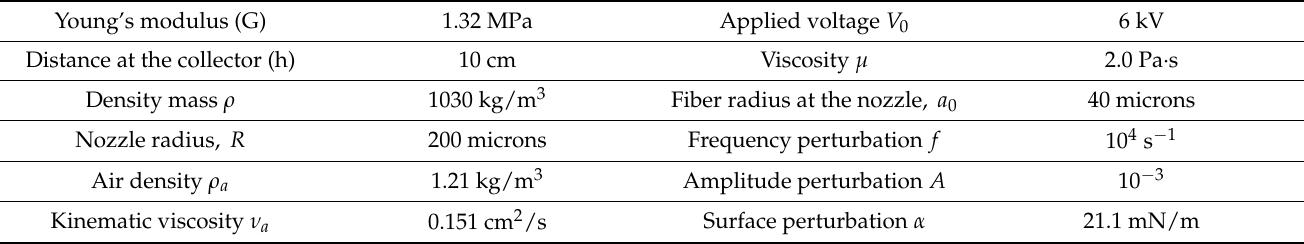
Table 3. Baseline simulation parameters used in the electrospinning process. Young’s modulus